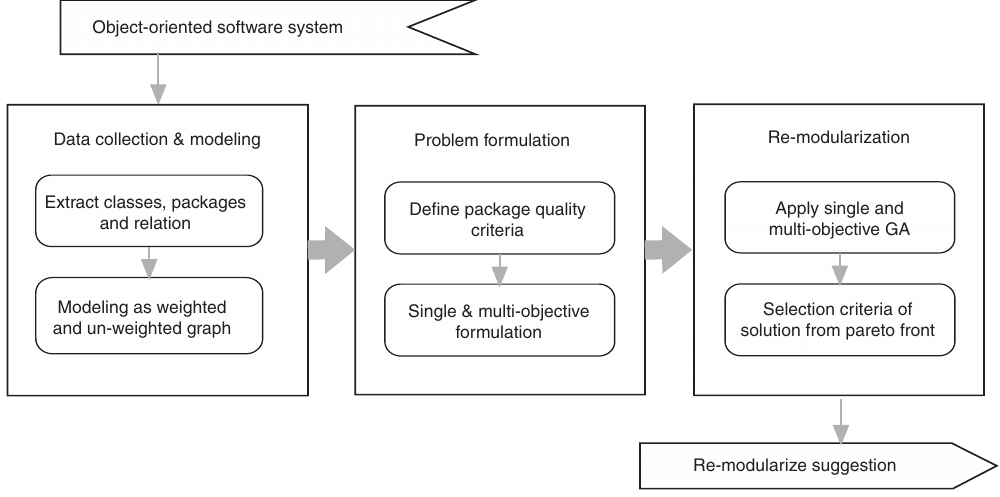
Figure 1: An Approach for Software